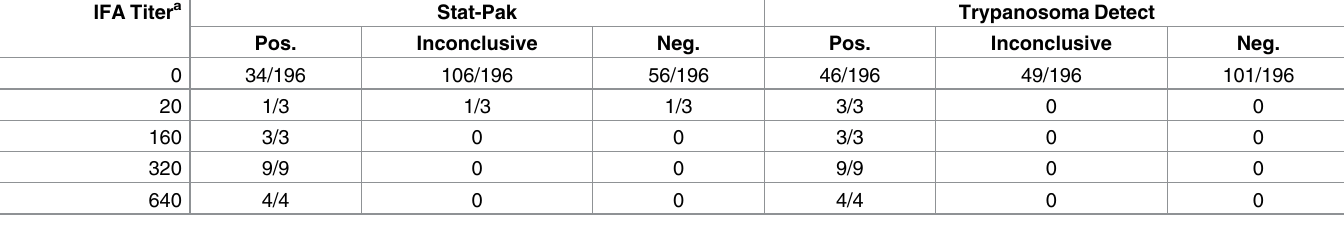
Table 4. Comparison of results from three serological assaysfor the detection of anti- T . cruzi antibodies: Chagas Stat-Pak rapid immunochroma- tographic test (ChemBio, NY), indirect fluorescent antibody (IFA) test performed by the Texas VeterinaryMedical Diagnostic Laboratory (TVMDL, College Station, TX) and Trypanosoma Detect(InBios, International, Inc., Seattle, WA). Number of sampleswith positive, inconclusive, or negative results on each test are given over the total number of sampleswith specifiedIFA endpointtiters. IFA Titer